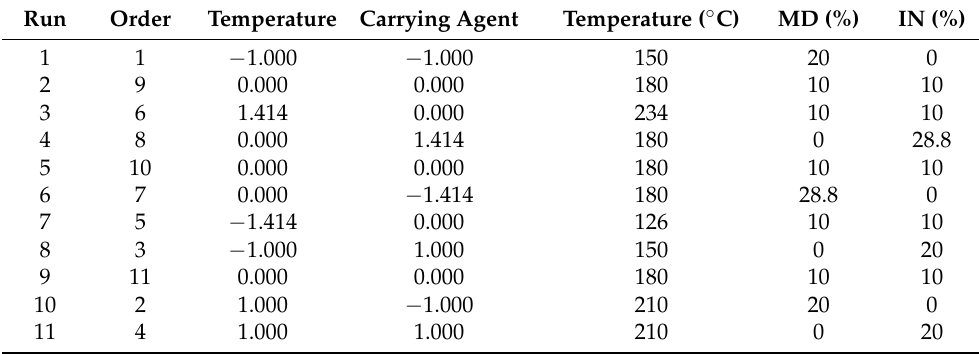
Table 1. Reduced experimental